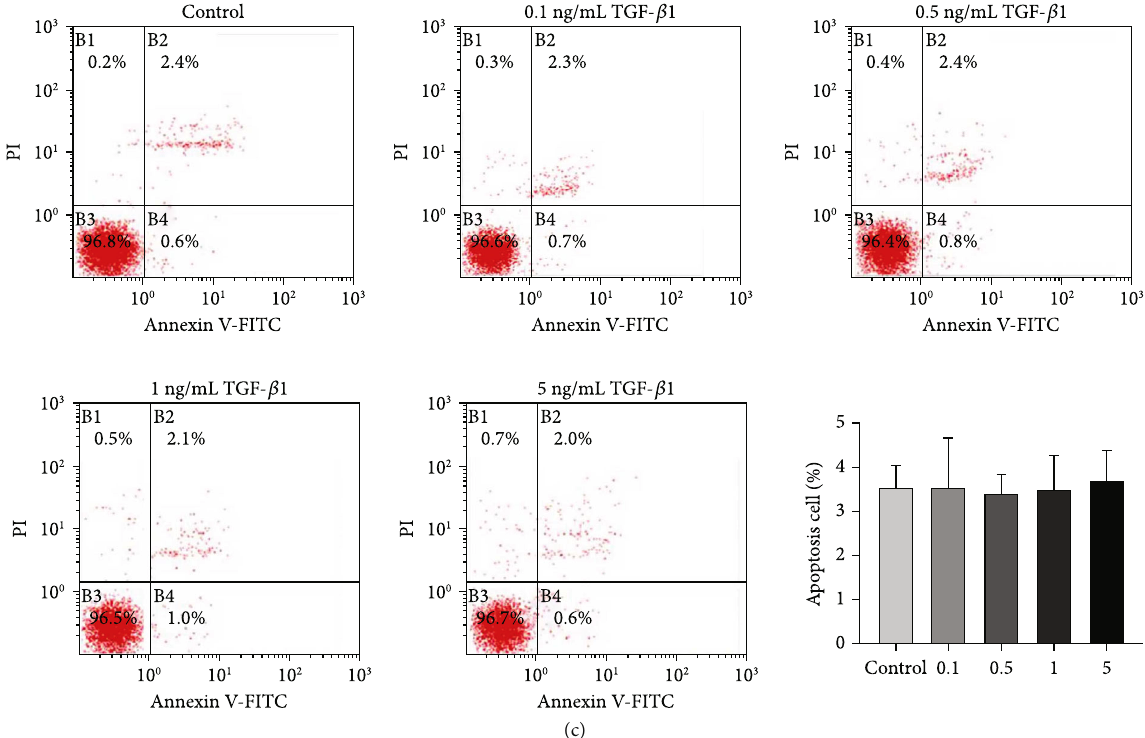
Figure 2: E ff ects of TGF- β 1 on cell behavior (a) CCK-8 assay of DPSCs proliferation after treatment with a range of concentrations of TGF- β 1 (0-5ng/mL) for 1, 3, 5, and 7 days. (b) Flow cytometry analysis showing changes in the cell cycle of DPSCs following treatment with a range of concentrations of TGF- β 1 for 48h. (c) Cell apoptosis following stimulation with the TGF- β 1 concentrations for 48h evaluated by fl ow cytometry. Error bars = means ± standard deviation (SD), n = 3 , statistically signi fi cant di ff erence at the levels ∗ p < 0 : 05 , ∗∗ p < 0 : 01 , and ∗∗∗ p < 0 : 001 (ANOVA) compared with the control group. CCK-8: cell counting kit-8; DPSCs: dental pulp stem cells; TGF- β 1: transforming growth factor- β